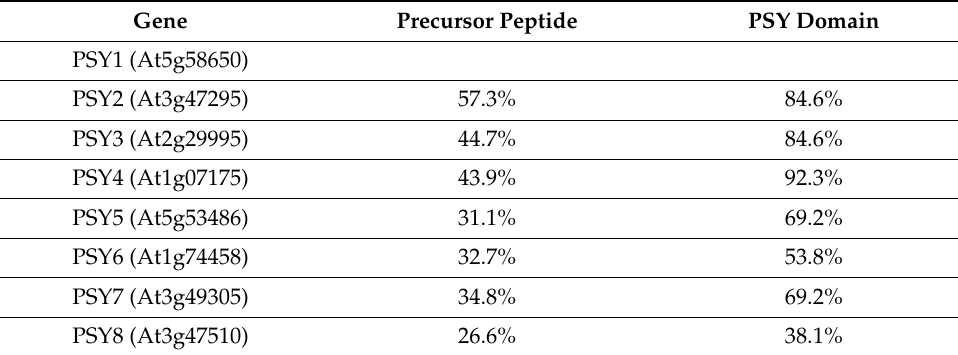
Table 2. PSY homolog’s similarity to